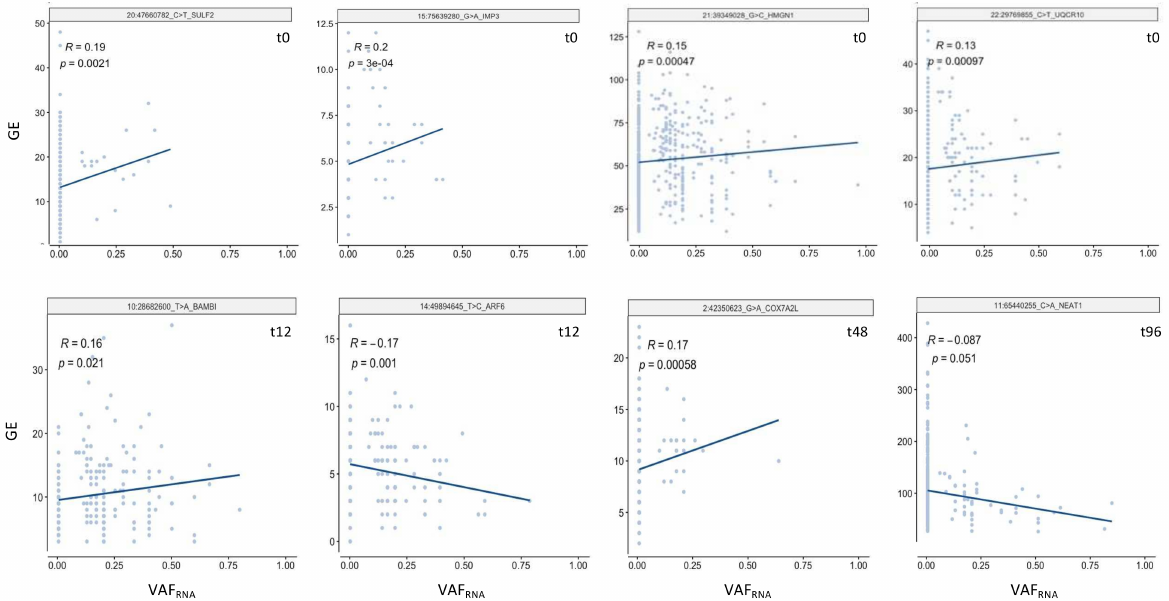
Figure 6. Examples of significant (FDR = 0.05) cis-scReQTL correlations between sceSNVs and the expression of their harboring